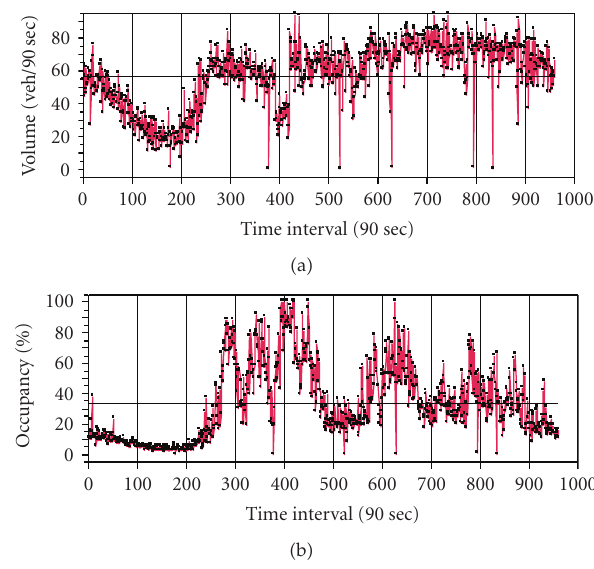
Figure 1: Time-series of volume (cid:3) vehicle/90 sec (cid:4) and occupancy (cid:3) % (cid:4) for a typical